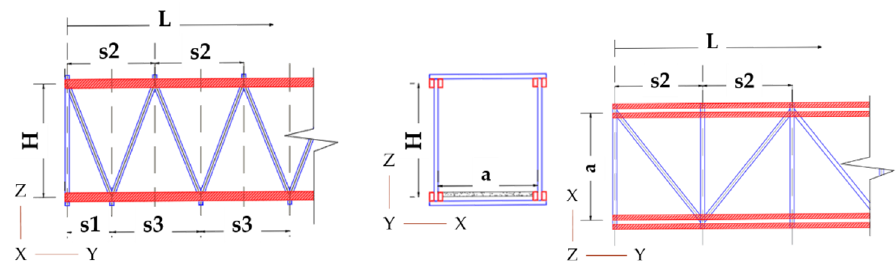
Figure 11. Geometry and cross-section of bridges (lateral, transverse and plan views). Table 3. Bridges geometry.